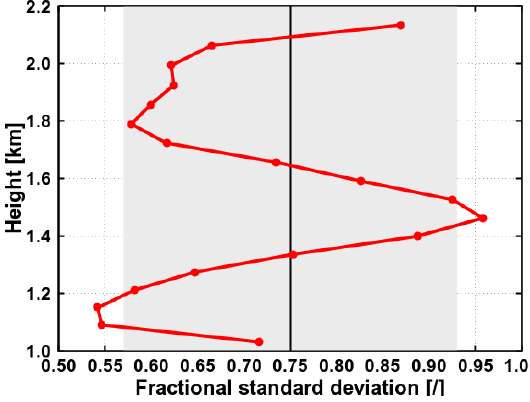
Figure 9. LWC profiles obtained with the LP method.